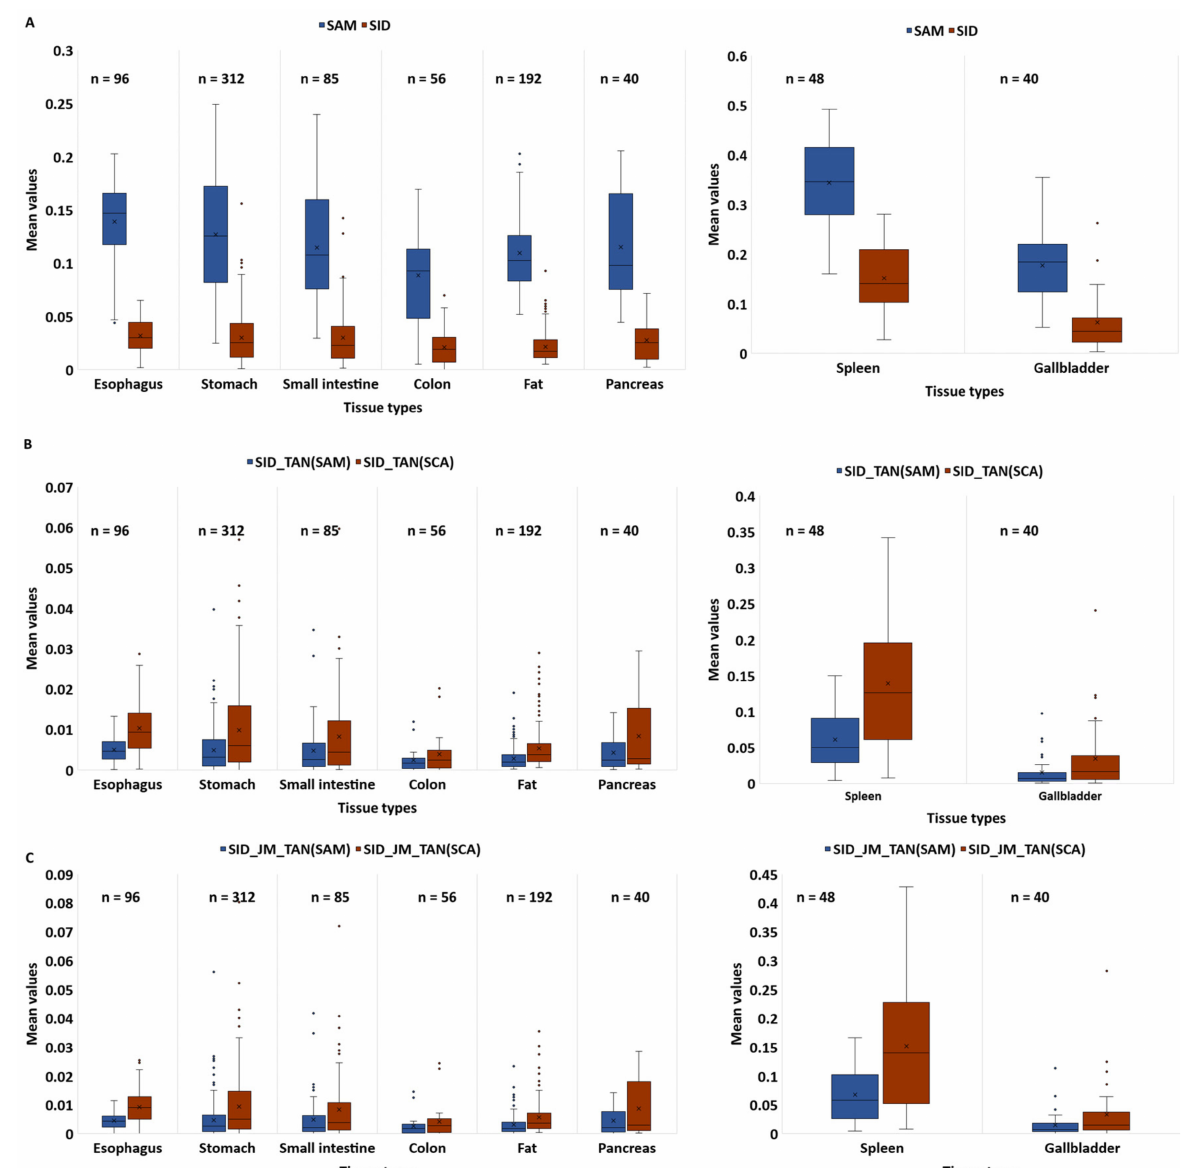
Figure 5. Averaged similarity values calculated by different methods to compare colon tissue with other tissues (e.g., esophagus, stomach, small intestine, colon, fat, pancreas, gallbladder, and spleen) (( A ) SAM and SID measures; ( B ) SID-TAN(SAM) and SID-TAN(SCA); ( C ) SID-JM-TAN(SAM) and